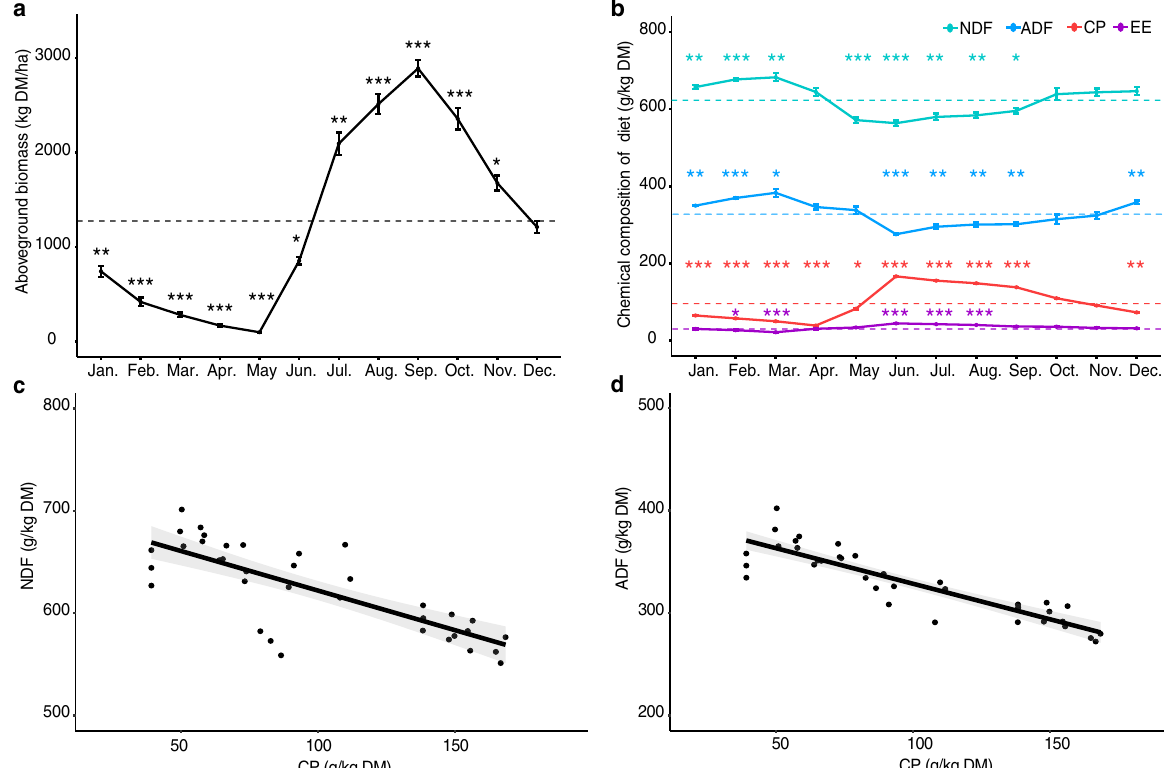
Fig. 3 Seasonal dynamics in above-ground biomass (AGB) and chemical composition (dry matter basis) of the diets year-round in the open-continuous grazing grassland. a Line chart represents the AGB (kg DM/ha). The dashed line is the mean AGB year-round. b Line chart represents chemical composition (crude protein (CP), ether extract (EE), acid detergent fi ber (NDF), and neutral detergent fi ber (ADF)) of diet year-round. The dashed lines are the mean of each chemical composition year-round and are colored by each chemical composition. Values and error bars are shown as means ± SE. Average contents of CP are correlated negatively with those of NDF ( R 2 = 0.59, p < 0.001) ( c ) and ADF ( R 2 = 0.78, p < 0.001) ( d ). Statistic tests are performed by the t -test with FDR (false discovery rate) corrected p -value, * p < 0.05, ** p < 0.01, *** p <